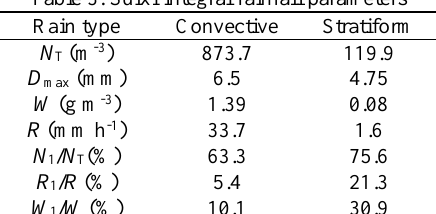
Table 3. Suixi integral rainfall